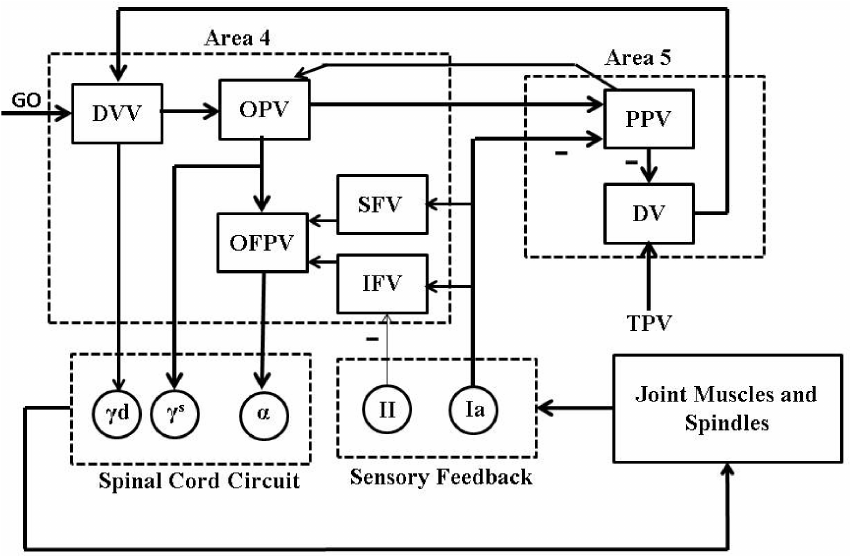
Figure 2. A psycho-physiological cortical circuit model for voluntary control of single joint movement: The diagram has been redrawn from Bullock et al. [21], Figure 1.1. Nomenclature (adopted from [21]): “GO” is a scalable gating signal; “DVV” is the desired velocity vector; “OPV” is the outflow position vector; “OFPV” is the outflow force and position vector; “SFV” is the static force vector; “IFV” is the inertial force vector; “PPV” is the perceived position vector; “DV” is the difference vector; “TPV” is the target position vector; “ γ d ” and “ γ s ” are dynamic and static gamma motoneurons respectively; “ α ” is alpha motoneuron; “ Ia ” and “ II ” are type Ia and II afferent fibers; − represents inhibitory